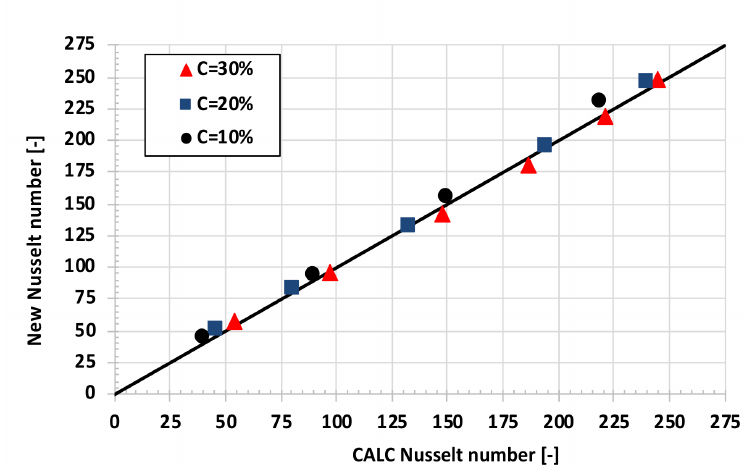
Figure 7. New Nusselt number expressed by (42) versus the Nusselt number predicted by the mathematical model for C = 10%; 20% and